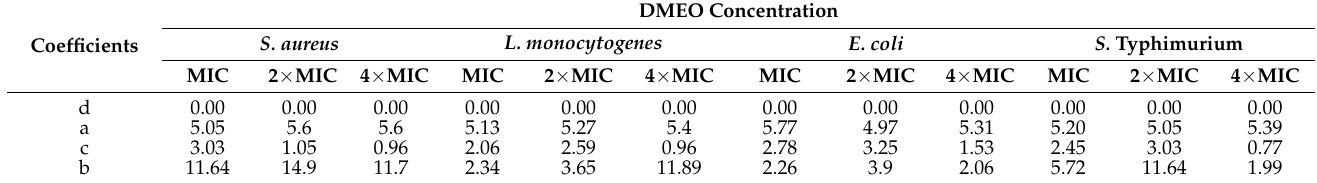
Table 6. Regression coefficients for time-kill kinetics models for DMEO-treated samples.